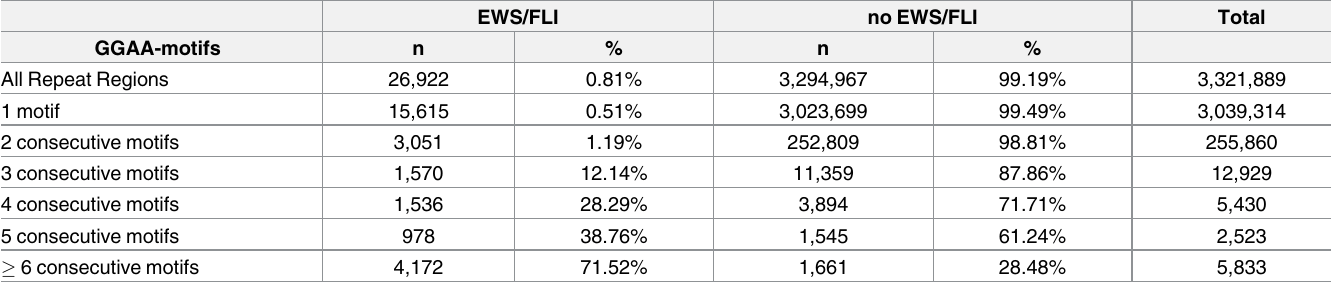
Table 1. Number of repeat regions and EWS/FLI binding